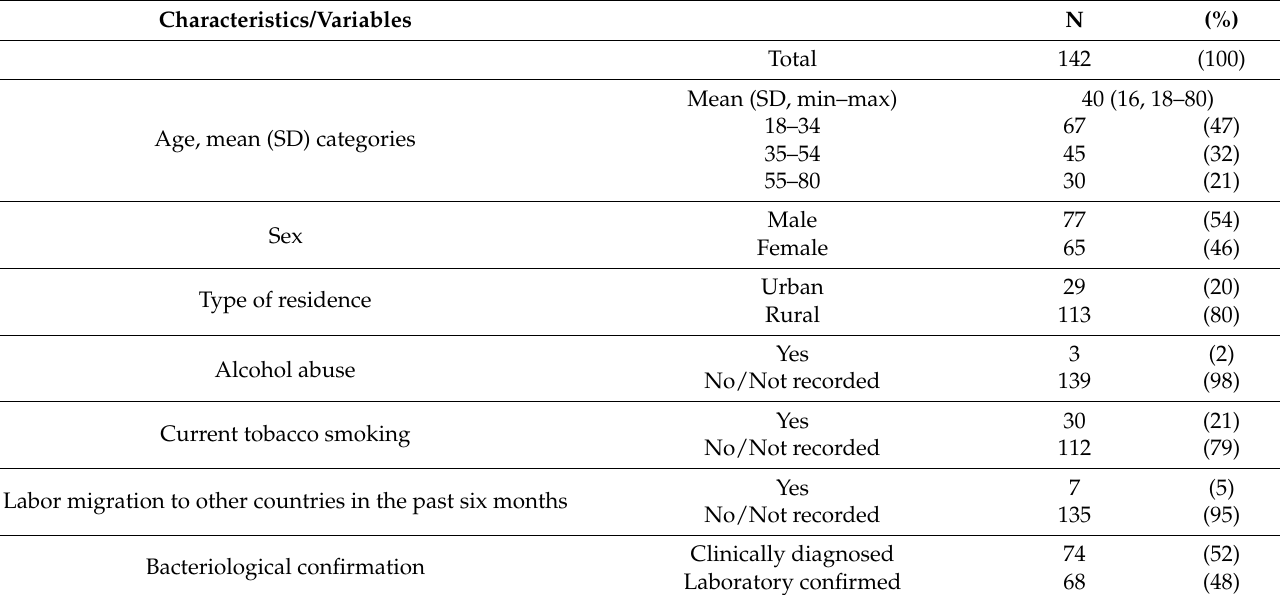
Table 1. Demographic, clinical, and diagnostic profile of patients with urogenital tuberculosis (UGTB) who received first-line treatment in Tashkent, Uzbekistan, from